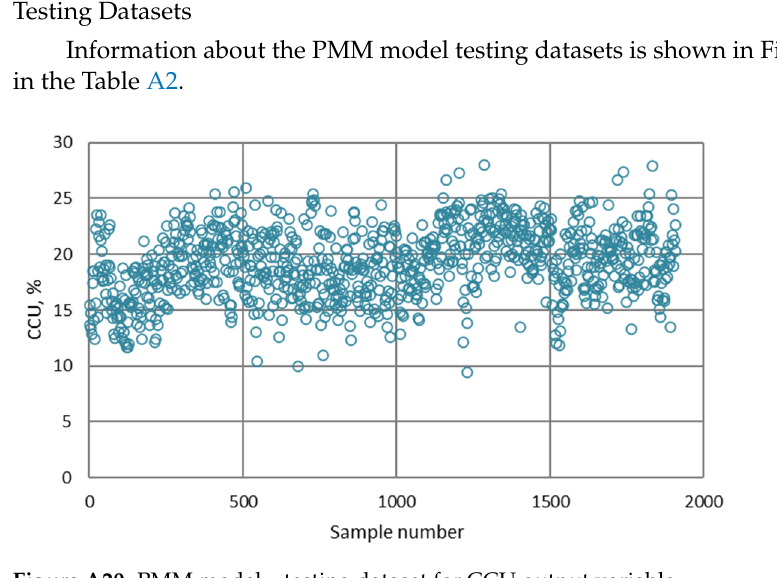
Figure A20. PMM model—testing dataset for CCU output variable.